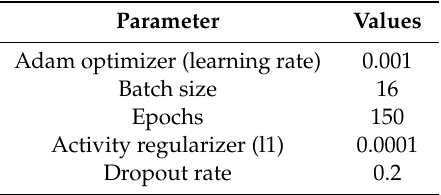
Figure 8. AE training. ( a ) Actual input and ( b ) reconstructed input. Table 1. Optimal parameter settings to train the AE model. Table 1. Optimal parameter settings to train the AE model Parameter Values Parameter Values Adam optimizer (learning rate) 0.001 Adam optimizer (learning rate) 0.001 Batch size Batch size 16 Epochs 150 Activity regularizer (l1) 0.0001 0.2 Dropout rate 0.2